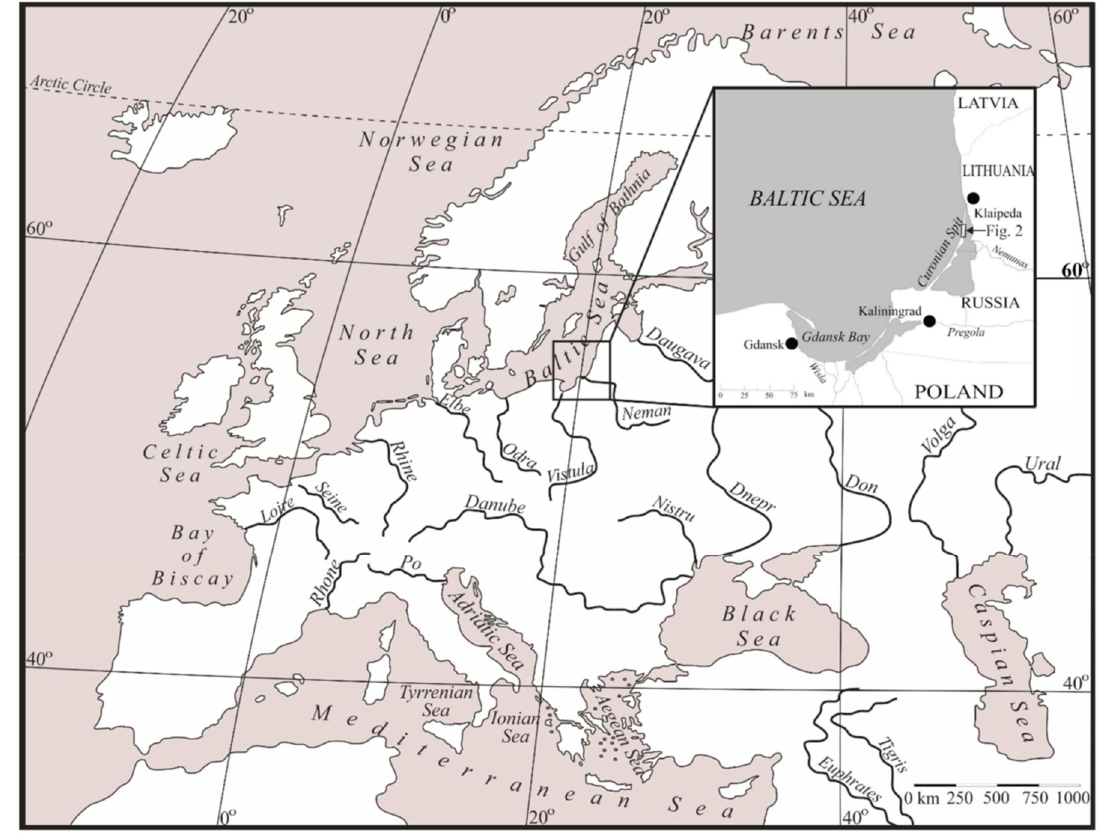
Figure 1. Location of the Curonian Spit on the southeast Baltic Sea coast. (Drawn by Arvydas Urbis).